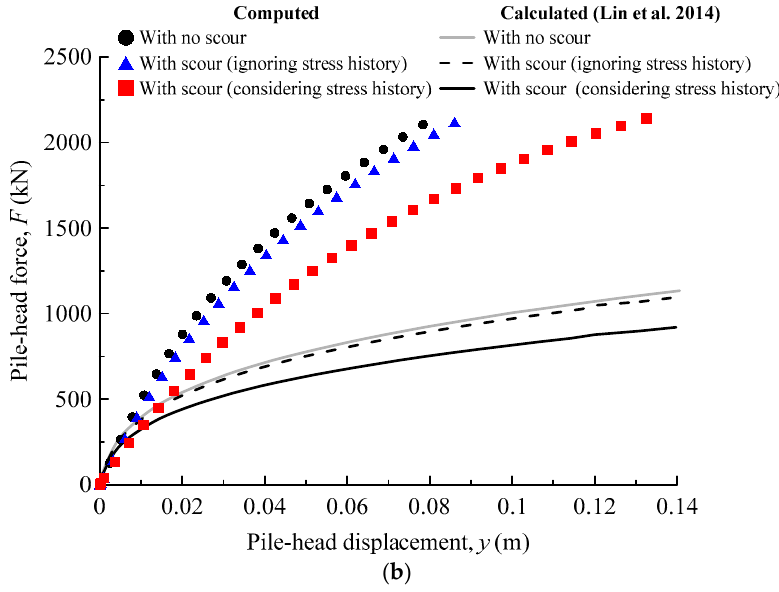
Figure 7. Comparison between the computed and calculated lateral load-deflection relationships at the scour depth of: ( a ) S d = 0.2 D ; ( b ) S d = 0.5 D . Table 3. Lateral deflection at pile head (m).